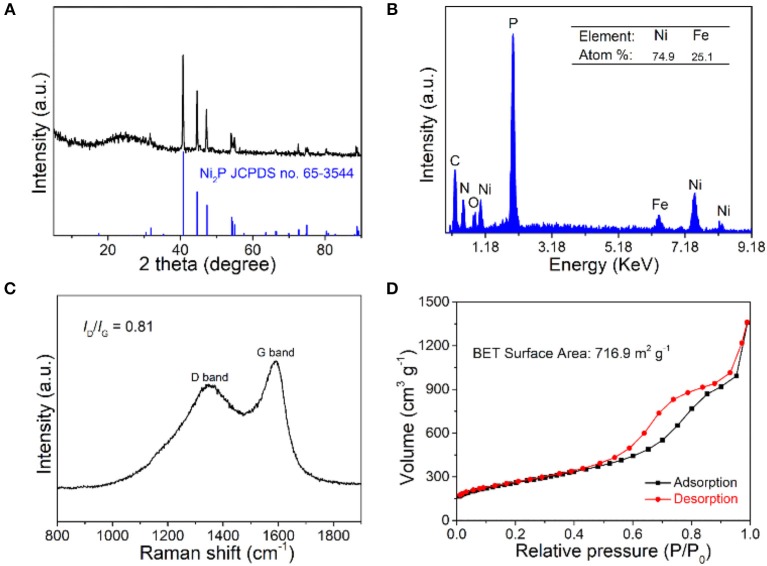
(A) XRD pattern, (B) EDX spectrum, (C) Raman spectra, and (D) N2 adsorption-desorption isotherm of Fe-Ni2P@N,P-CNSs.